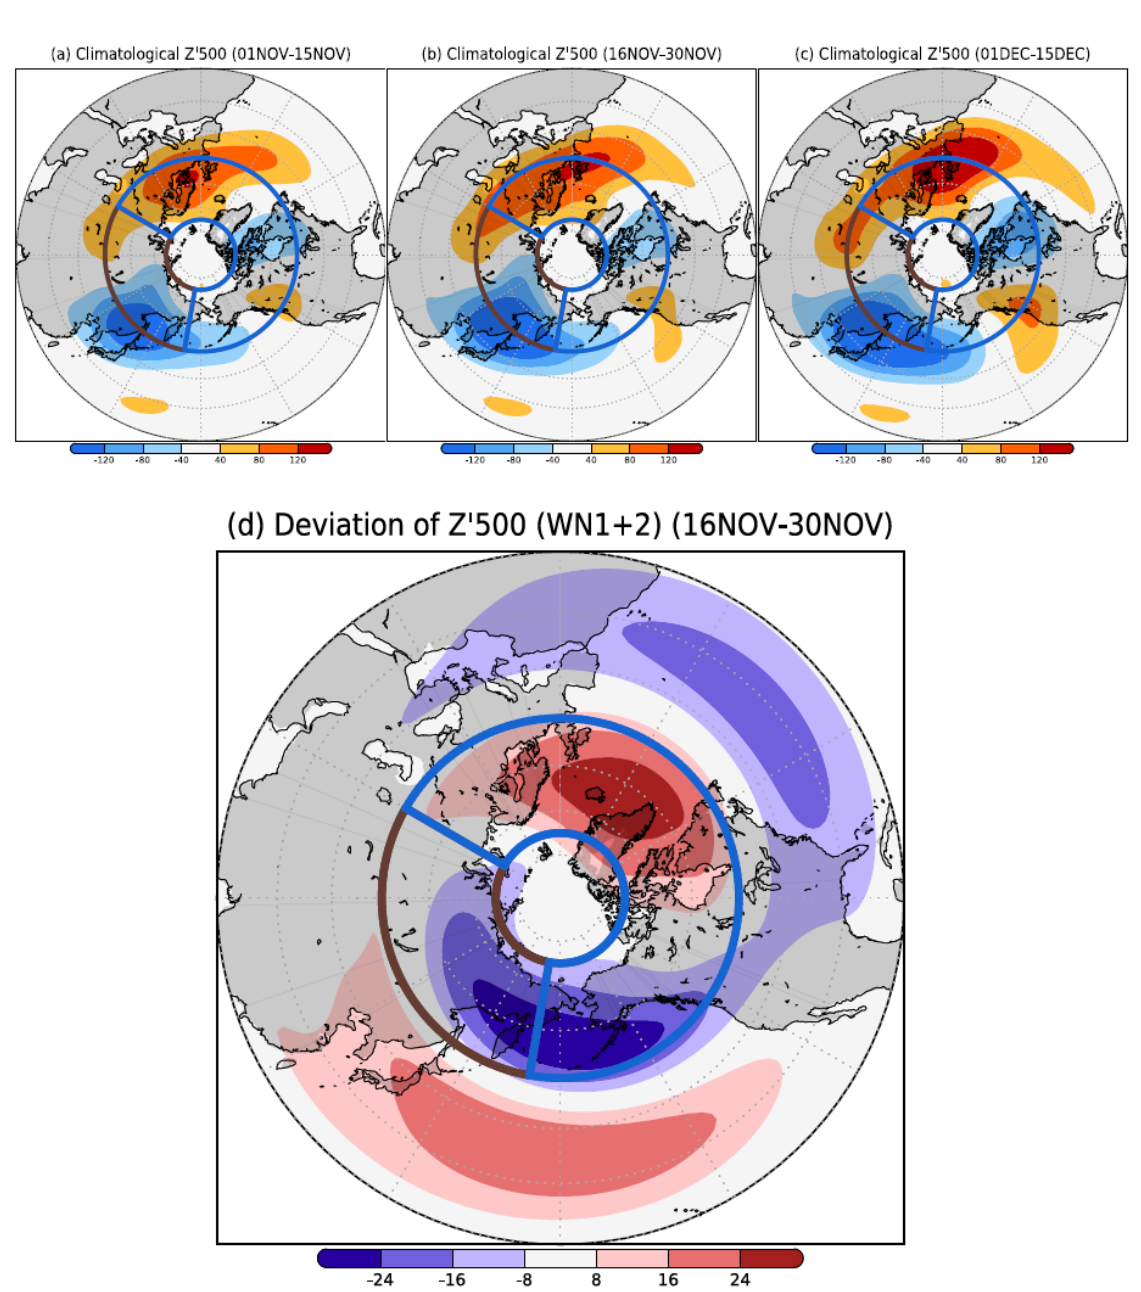
Figure D5. Zonal anomalies of climatological geopotential height at 500hPa (m) during (a) early November, (b) late November, and (c) early December. (d) Late November deviations calculated by Eq. (4) (see Sect. 3.3) with wavenumber decomposition; only planetary-scale compo- nents, wavenumbers 1 to 2, were used. The brown (60–170 ◦ E, 50–75 ◦ N) and blue (170 ◦ E–60 ◦ W, 50–75 ◦ N) boxes indicate the averaging areas used for calculating the fields shown in Fig.